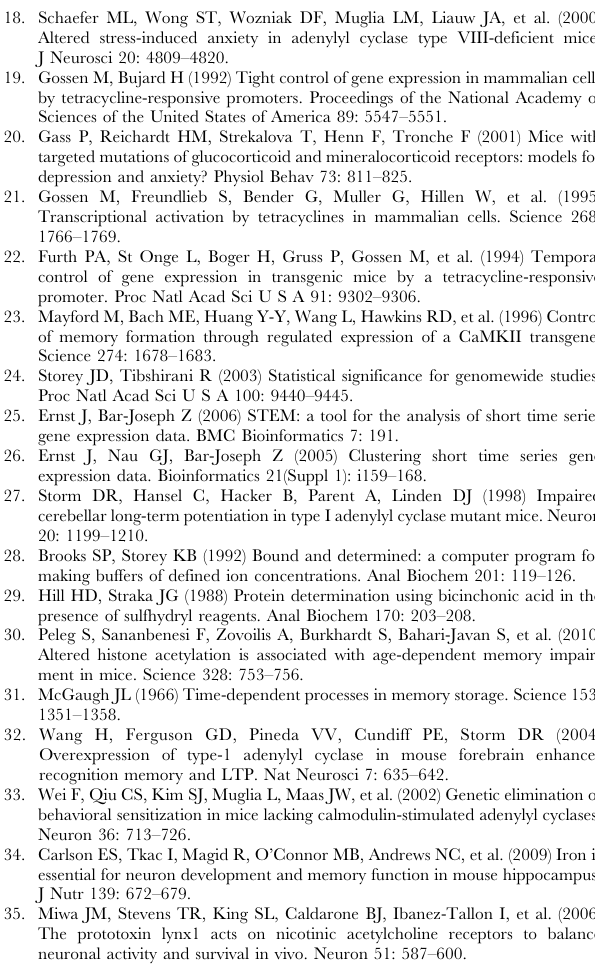
Table S9 Hippocampus gene cluster list. The table lists the genes represented within each cluster in the hippocampus.